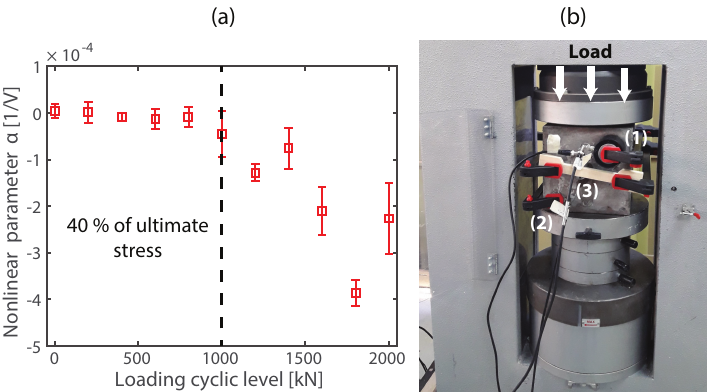
Figure 7. NCWI results for different loading cyclic level. ( a ) Nonlinear elastic hysteretic parameter as a function of the amplitude of the loading cyclic from 10 to 2000 KN indicating the material softening process. ( b ) Experimental setup with ultrasonic probes (1 coda emitter, 2 coda receptor and 3 SW pump-wave source) on the front face of the cubic sample coupled by shear-wave paste and fixed by clamps. For each loading cycle, the NCWI test was performed immediately after to release the load within about 10